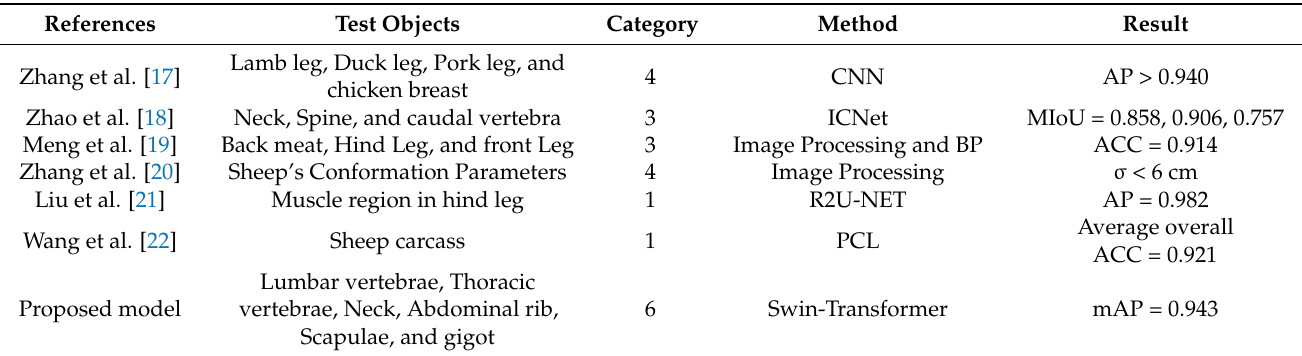
Table 4. Comparison of the proposed model with existing related